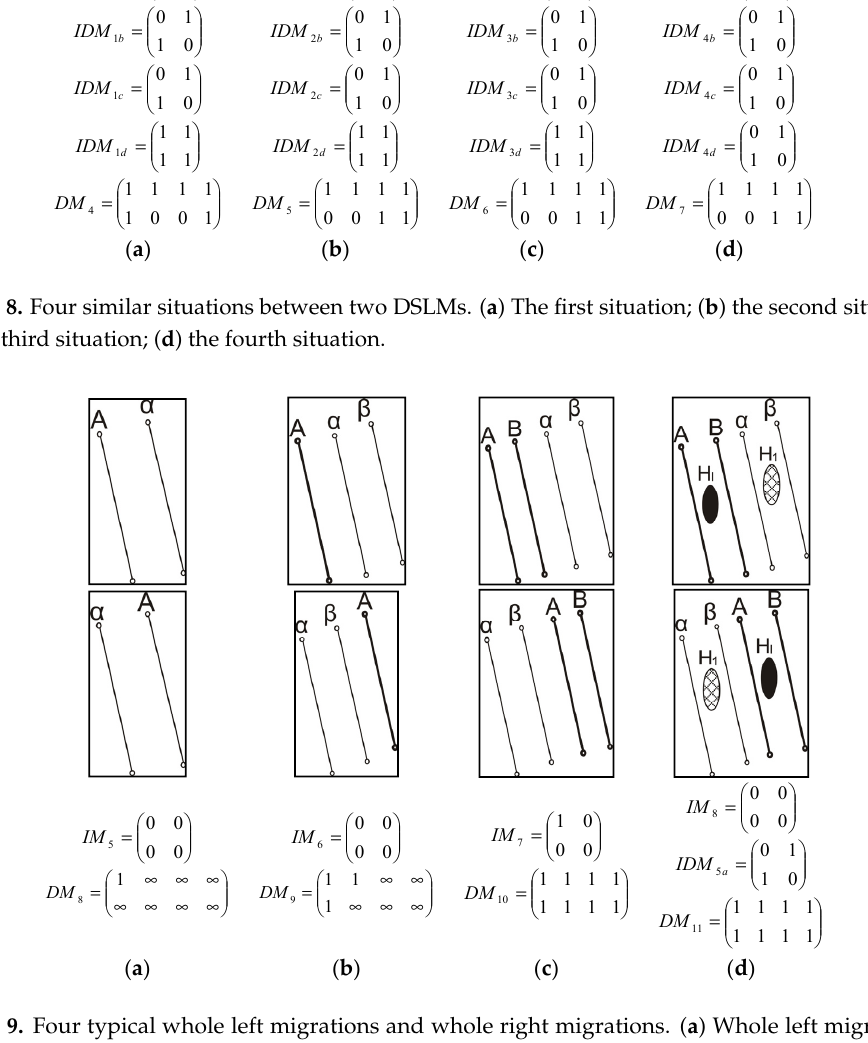
Figure 9. Four typical whole left migrations and whole right migrations. ( a ) Whole left migrations and whole right migrations between two SSLMs; ( b ) whole left migrations and whole right migrations between one SSLM and one DSLM; ( c ) whole left migrations and whole right migrations between two DSLMs; ( d ) whole left migrations and whole right migrations between two